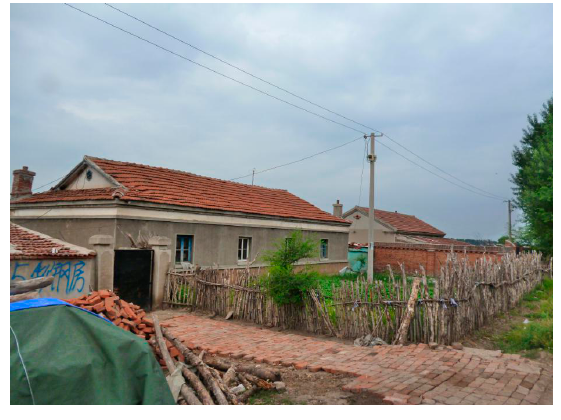
Figure 3. Housing in the original village.